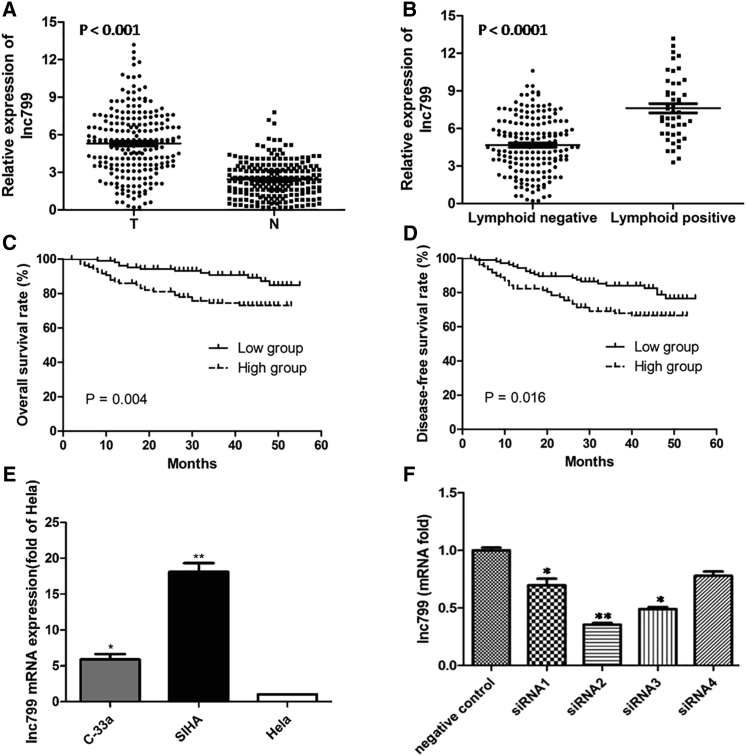
lncRNA799 Expression Was Detected by qRT-PCR(A) lncRNA799 expression was significantly upregulated in cancerous tissues compared with the corresponding normal tissues. (B) lncRNA799 expression was significantly higher in patients with lymph node metastasis. Kaplan-Meier survival curve analysis showed that patients with higher lncRNA799 expression had poorer (C) overall survival and (D) disease-free survival compared with patients with lower lncRNA799 expression. (E) lncRNA799 expression in different cervical cancer cell lines. (F) Downregulation of lncRNA799 expression in cervical cancer cell lines. Expression levels are normalized to GAPDH. Error bars represent SE. The results are from three independent experiments and reported as mean ± SD values. *p < 0.05; **p < 0.01.